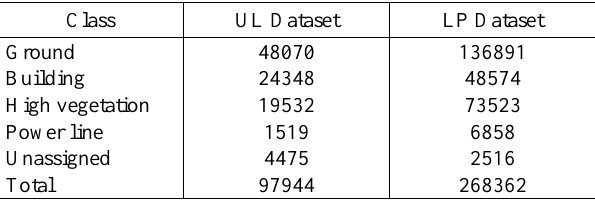
Table 1. Number of labelled 3D points in the two datasets.